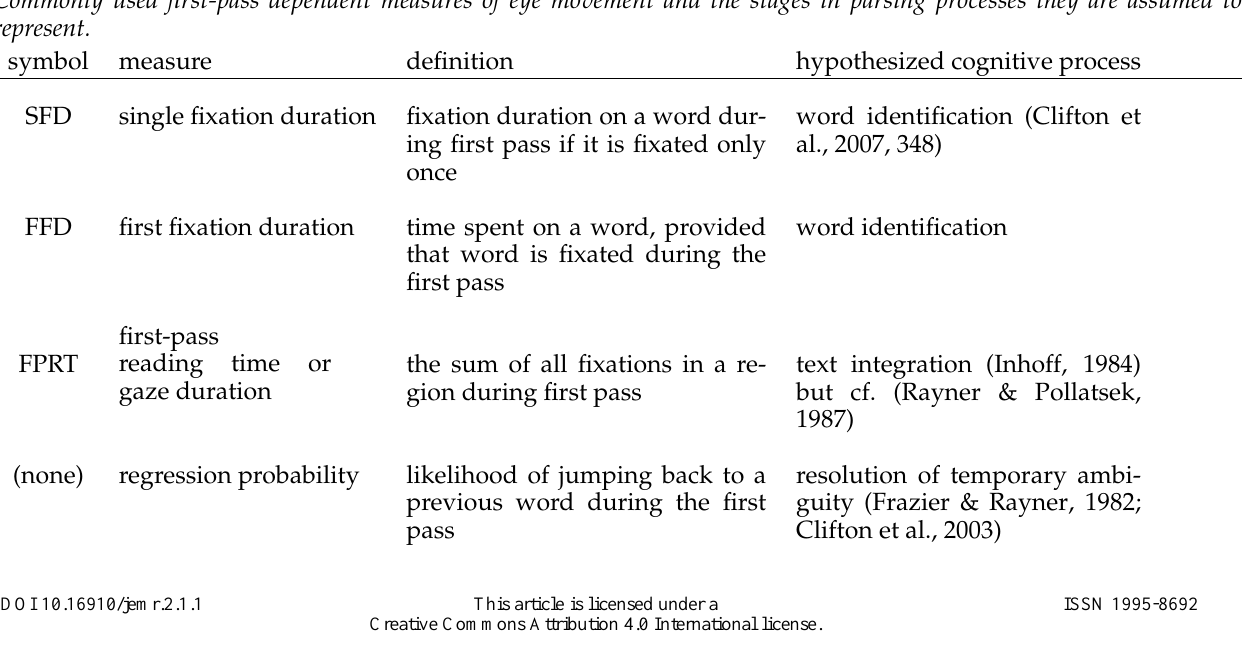
Commonly used first-pass dependent measures of eye movement and the stages in parsing processes they are assumed to